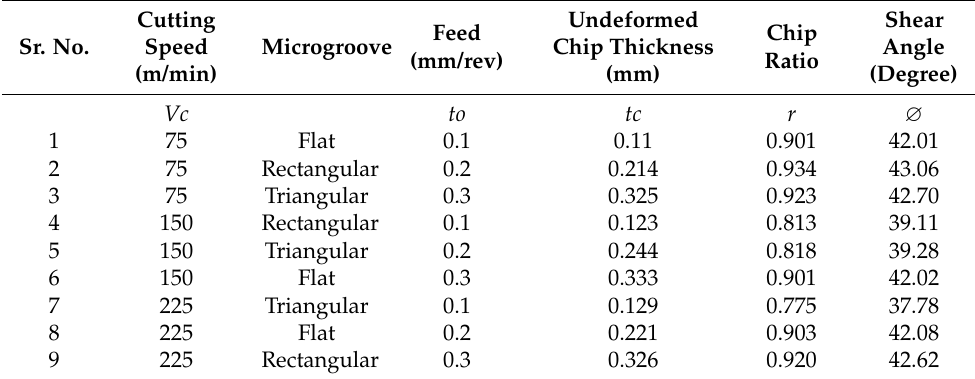
Table 6. Calculation of Chip Compression Ratio and Shear